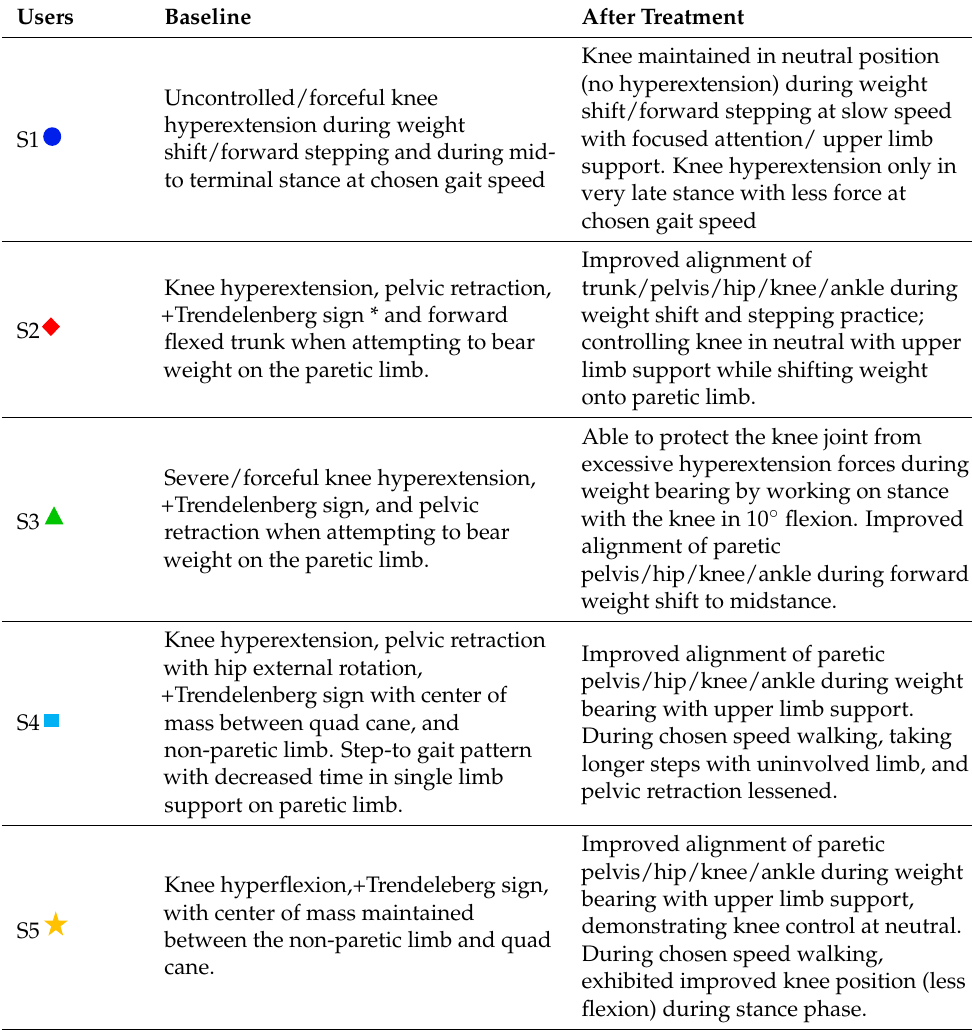
Table 4. Changes in Paretic Limb Stance Control. Table 1. Participants characteristics.